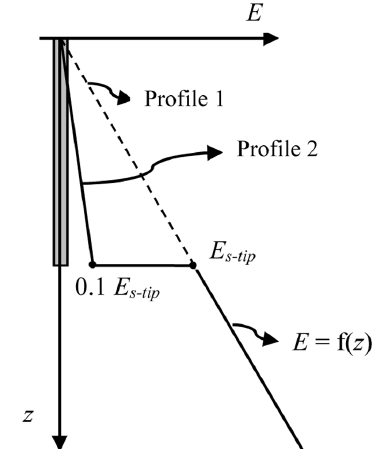
Fig. 12. Two different profiles assumed for the soil elastic modulus: linear profile versus profile with reduced soil modulus along the pile shaft